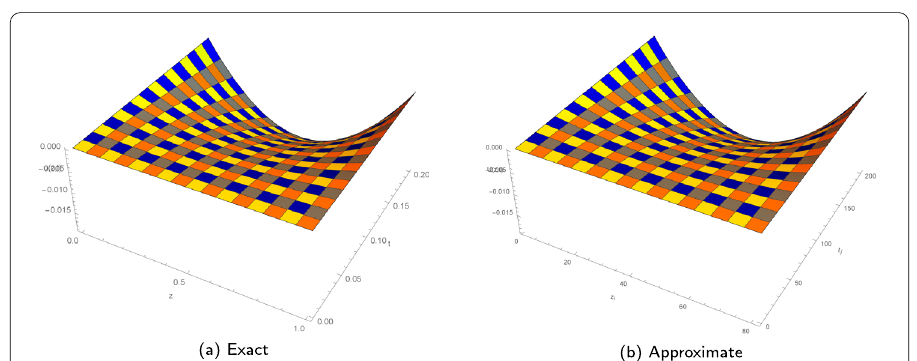
Figure 2 Exact and numerical solutions for Example 1 when N = 80, α = 0.6, t = 0.2, and (cid:3) t =